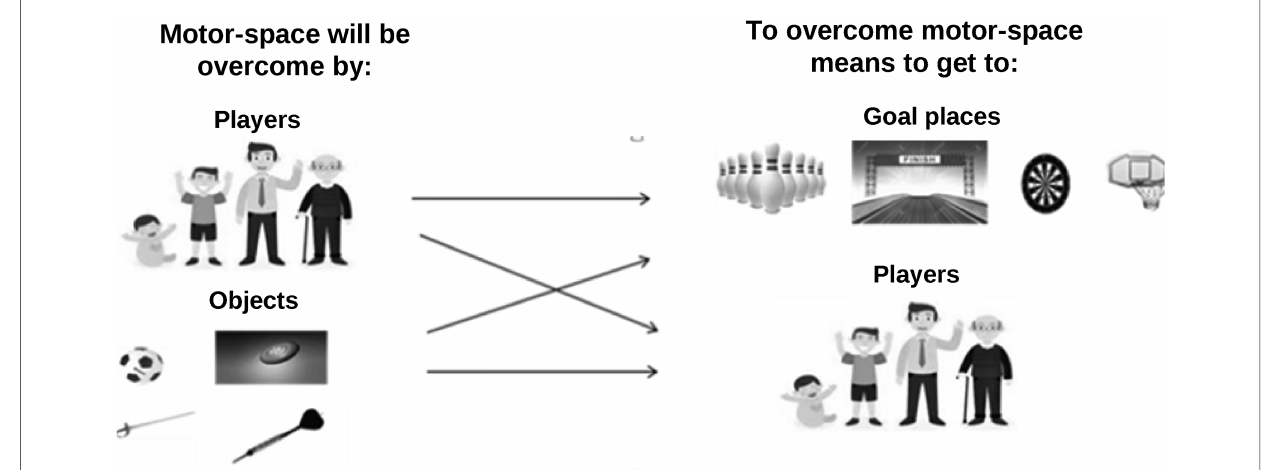
FIGURE 2 Combinations between the two options of the two components based on the goal of game “ to overcome motor-spaces ” (arrival component and component that overcomes the motor-space to the arrival